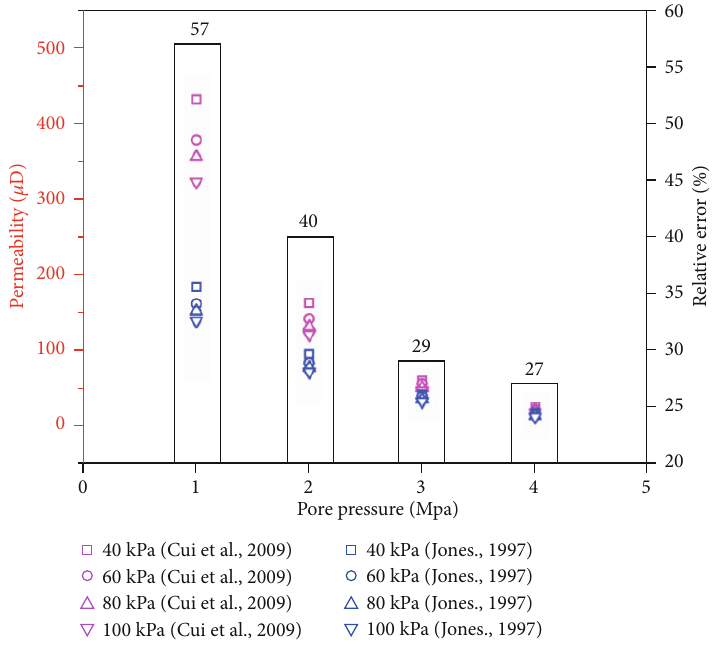
Figure 4: Comparison of the carbon dioxide permeability of coal calculated by Jones ’ and Cui et al. ’ s method.